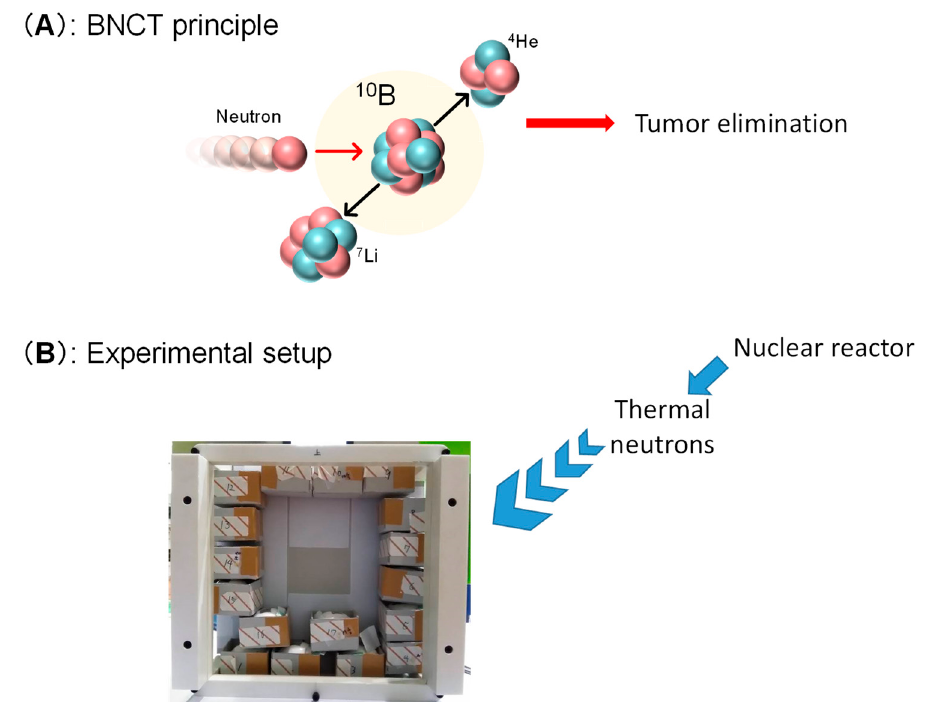
Figure 6. Boron neutron capture therapy ( BNCT) principle and experimental setup. ( A ) BNCT principle involves irradiation of boron-10 with thermal neutron; ( B ) Egg holders were placed in a cardboard box and irradiated with thermal neutron from a nuclear reactor. The neutron beam was irradiated from the back of the cardboard box.